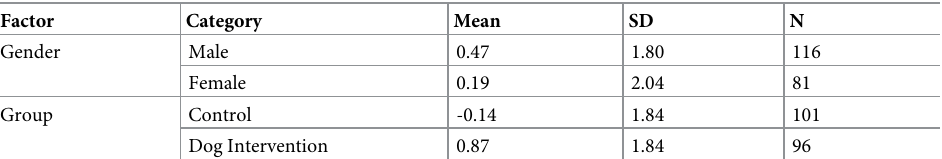
Table 13. Descriptive statistics for wellbeing.